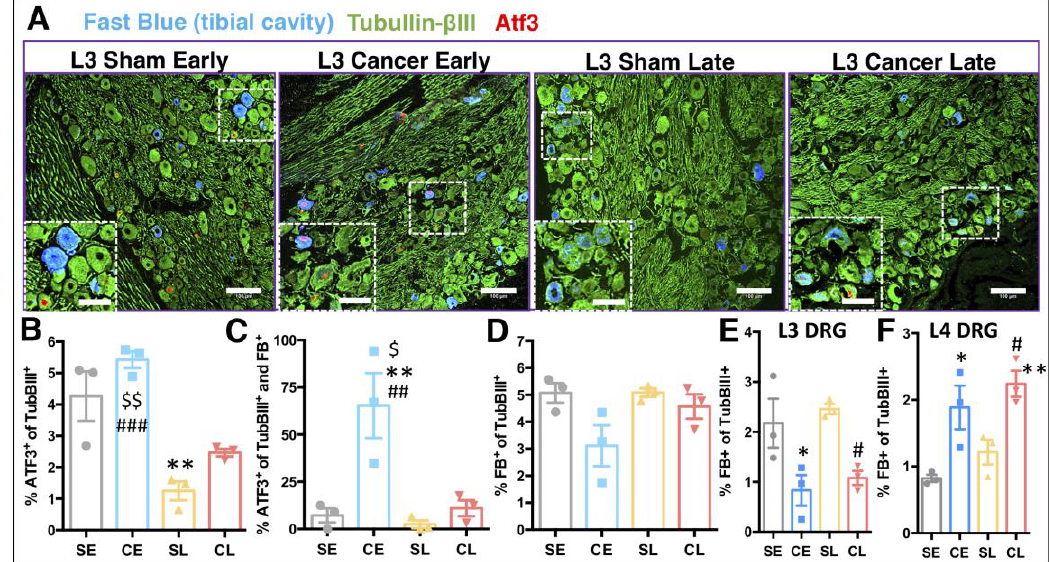
Figure 5. Cancer progression a ff ects bone innervation. ( A ) Representative confocal scans selected from lumbar 3 dorsal root ganglion (DRG) of immunohistochemical analysis of cellular stress factor activating transcription factor 3 (Atf3) and tubulin- β III protein expression in the fast blue (FB) traced tibial a ff erents. FB was injected a week before the cancer cells or vehicle (sham) implantation. Main scale bars are 100 µ m, and zoomed inclusions’ scale bars are 50 µ m. ( B ) Quantification of all Atf3 + a ff erents within ipsilateral L2–5 DRG, analysed as a percentage of all neurons (tubulin- β III) therein in cancer early (CE, day 7 / 8) and cancer late (CL, day 14/15) stage groups with corresponding sham On average 4–20 10 µ m sections were counted per DRG. Data represent the mean ± SEM and each